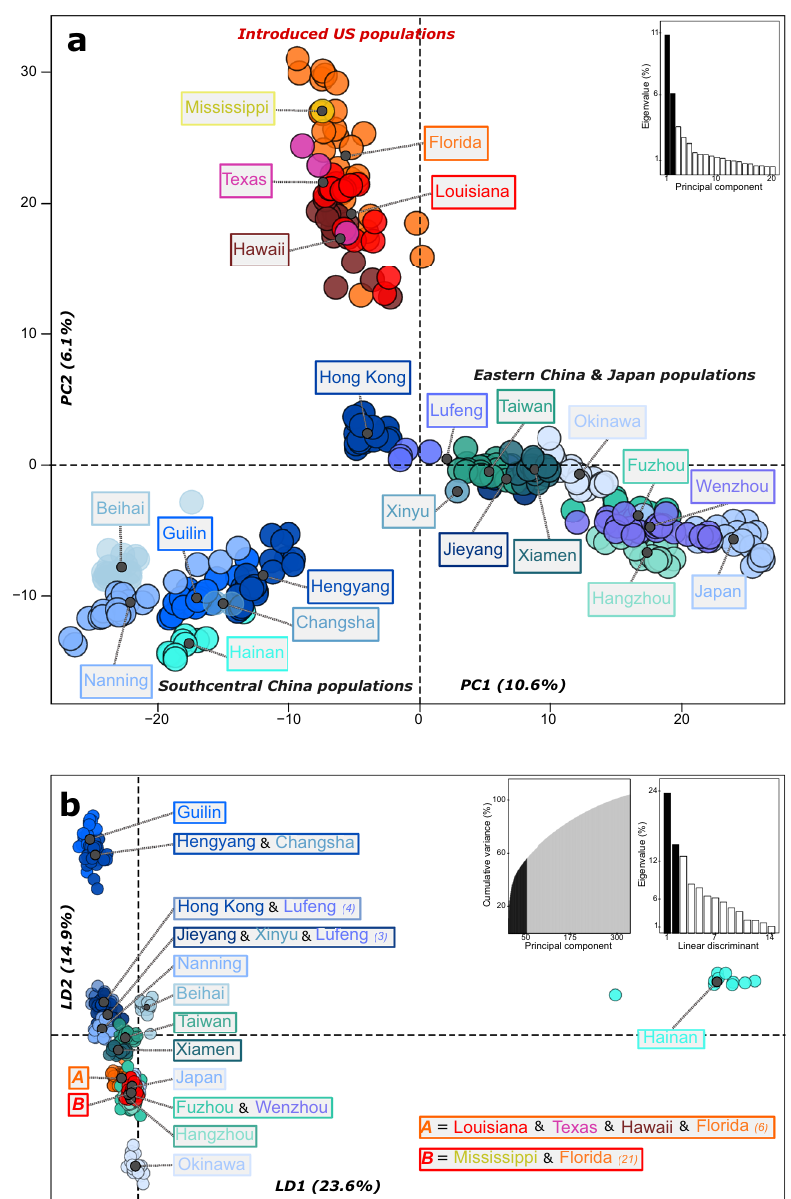
Fig. 2 Population substructure in the global C. formosanus population. a Principal component analysis (PCA) of all C. formosanus individuals. The axes represent the fi rst two principal components (PC). Only the fi rst 20 PC ’ s (out of 324) are shown in the eigenvalue inset graph, with the black bars representing the two plotted PCs. b Discriminant analysis of principal components (DAPC) with best support for K = 15 genetic clusters. The axes represent the fi rst two linear discriminants (LD). The fi rst inset graph shows the cumulative variation explained by the PCs, with only the PCs in the black shaded area utilized for the DAPC. The second inset graph depicts the eigenvalues for all linear discriminants, with the black bars representing the two plotted